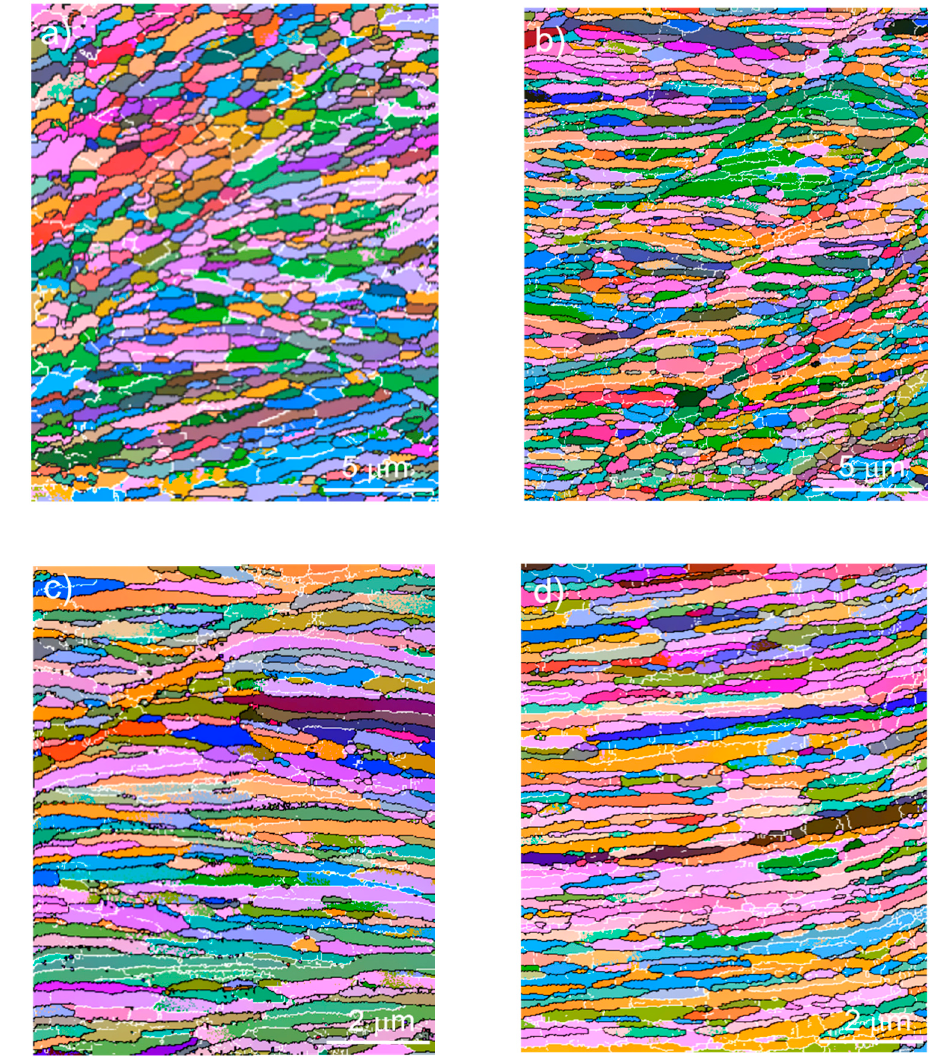
Figure 4. Example EBSD maps showing the submicron grained Al-0.13%Mg alloy deformed by PSC to a true strain of 2.1 at ( a ) 298 K, ( b ) 213 K, ( c ) 143 K and ( d ) 77 K. Note the different magnifications used in the EBSD maps and RD is horizontal.